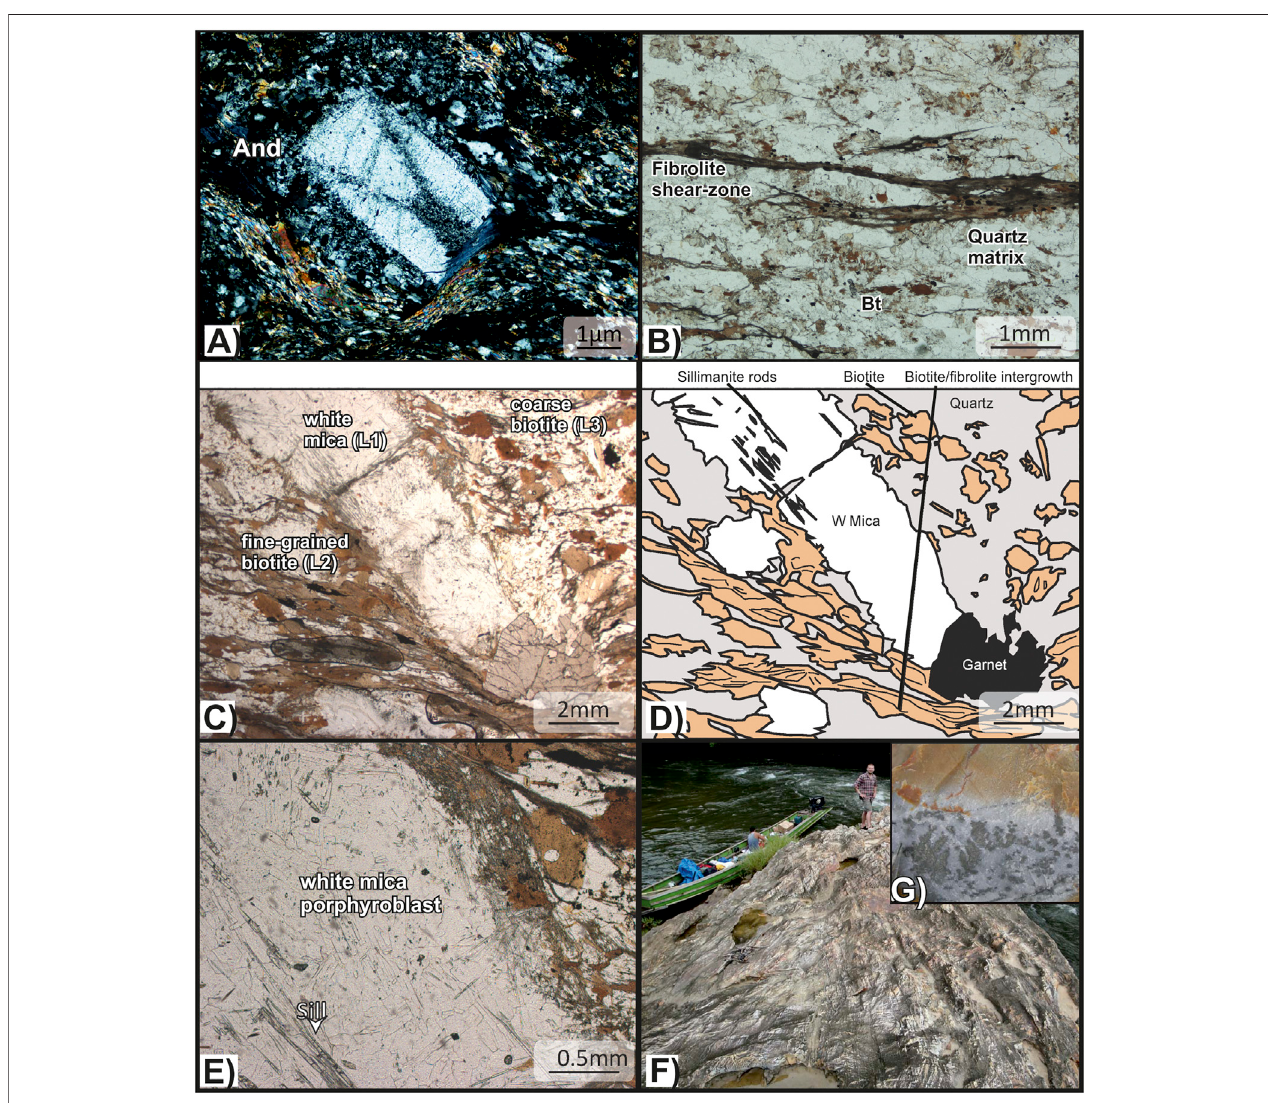
FIGURE13| Representative fi eldphotographsandphotomicrographsofmetamorphicrocksoftheSchwanerMountains. (A) Photomicrograph(XPL)ofandalusite porphyroblast with chiastolite-type inclusion trail morphology (LD10-064, andalusite-cordierite schist). (B) Photomicrograph (PPL) of fi brolitic sillimanite growth along shear fabric in biotite schist (LD10-004B). (C, D) Photomicrograph (PPL and sketch) of garnet-sillimanite schist LD10-084. Shear fabric of sillimanite-biotite intergrowth deforms around white mica, biotite and garnet porphyroblasts. (E) Photomicrograph (PPL) of replacement white mica pseudomorph showing abundant sillimanite rods. (F) Quartzite outcrop in river section showing remnants of compositional layering (LD10-058). Close-up of quartzite hand specimen with alteration on surface.